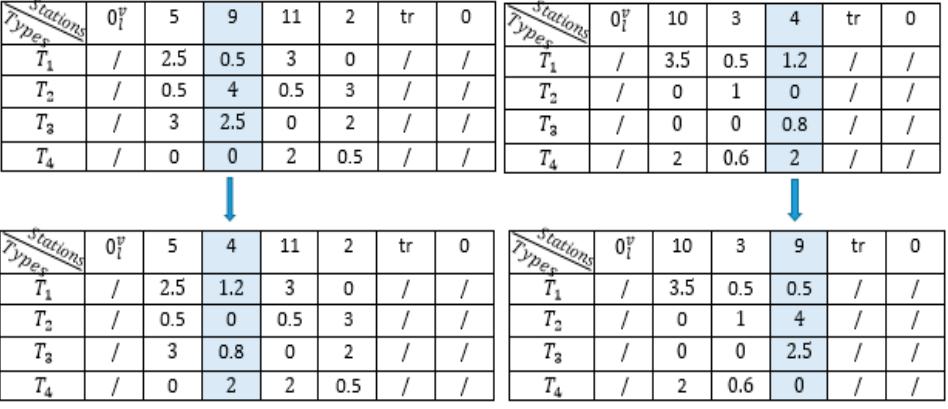
Figure 11. Example of Mutation procedure.